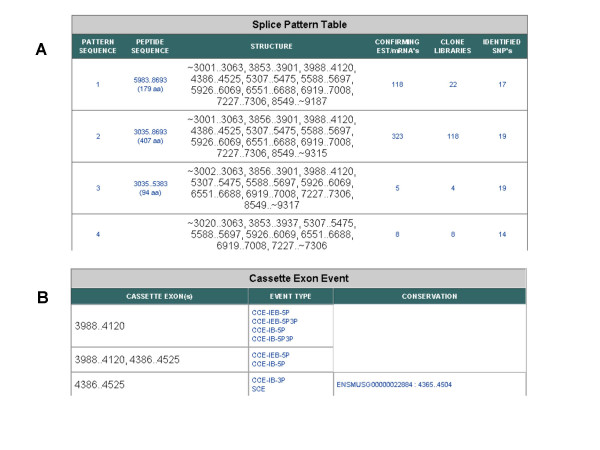
Example of splice pattern table and splice event table. Locations of exons are as on the gene.Inset A: Entry in column 1 is hyperlinked to a page listing the sequence of the splice pattern. Entry in column 2 gives the coding start & end positions on the gene and the length of the translated peptide sequence and is hyperlinked to a page listing the peptide sequence. Entry in column 3 lists the structure of the splice pattern as a string of exons. Entry in column 4 is hyperlinked to pages listing detailed information on the confirming transcript sequences. Entry in column 5 is hyperlinked to pages listing EST/mRNA sequences. Entry in column 6 is hyperlinked to pages listing allele specificity of the splice pattern. Inset B: Column 1 lists the exons involved in the event (in this example cassette exon event). Column 2 indicates whether the event involves modifications in the flanking exons as well; entries are hyperlinked to pages listing detailed information on the event. Column 3 indicates the identifier of the orthologous gene and the coordinates of the exon orthologous to the one presented in column1; the entry is hyperlinked to the orthologous gene entry.